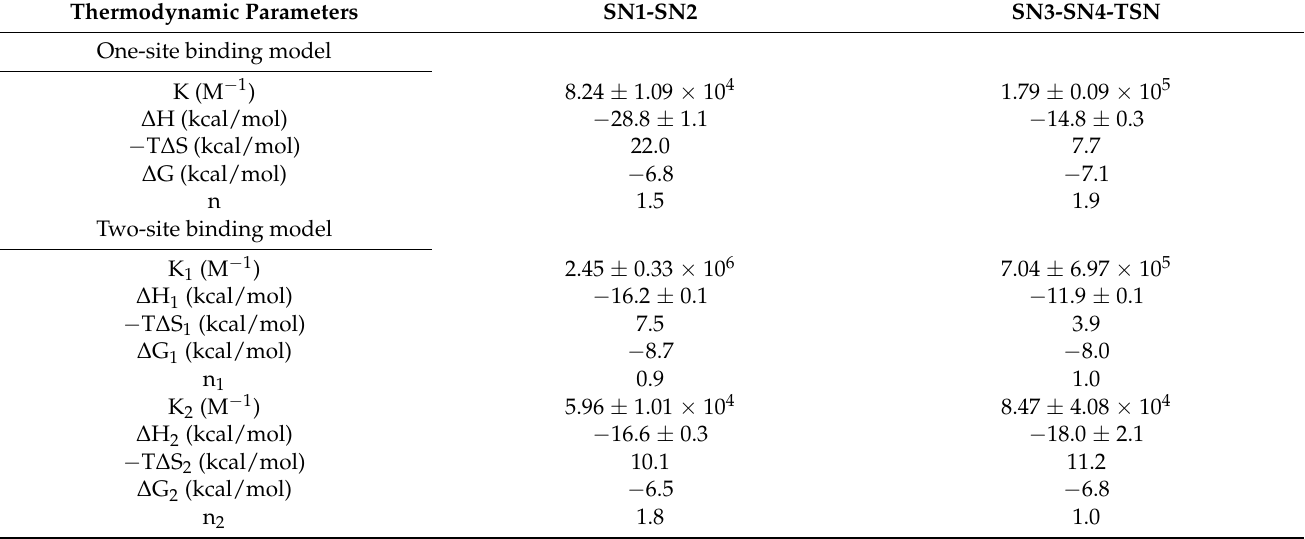
Table 2. Thermodynamic parameters of suramin binding to SN1-SN2 and SN3-SN4-TSN with ITC. Thermodynamic